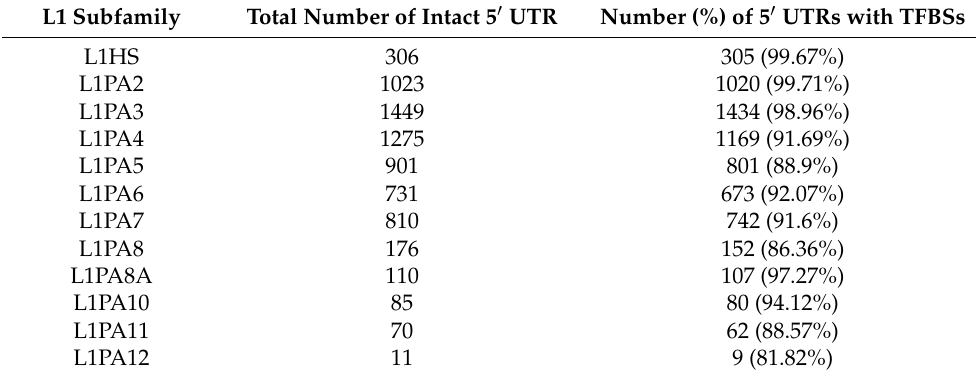
Table 1. Number of total and TF-bound L1 5 (cid:48) UTRs in MCF7